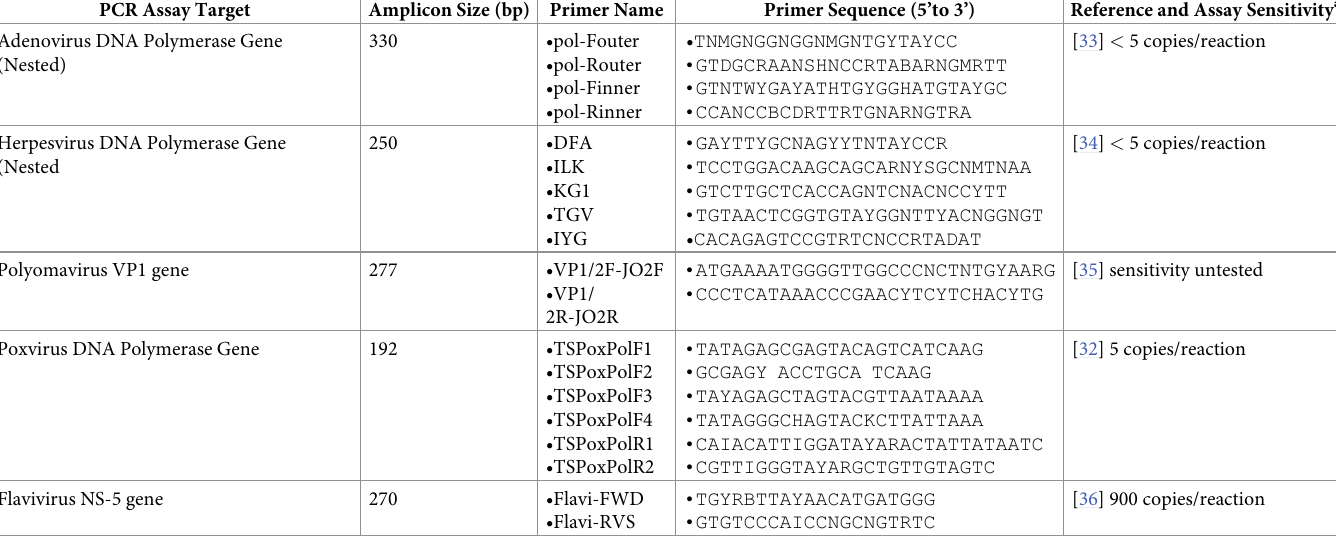
Table 1. Primer sequences and reference methods for PCR assays conducted on samples of deer Case